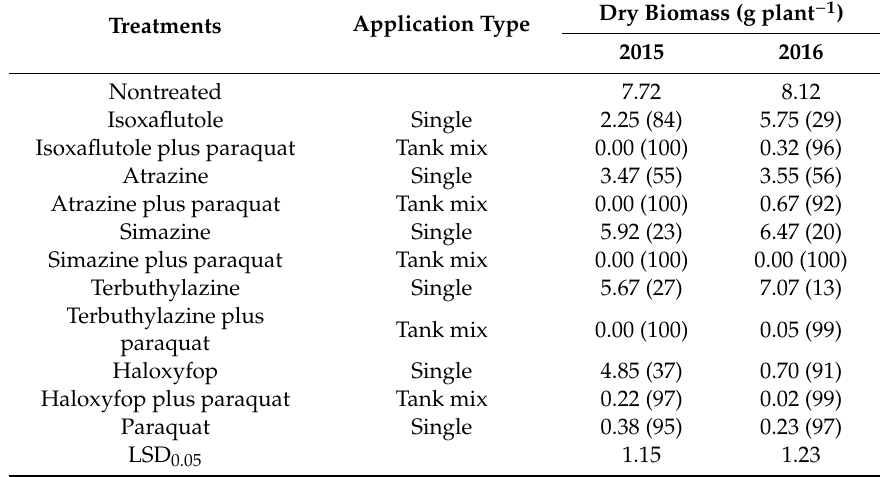
Table 3. E ff ect of single and tank mixture herbicide treatments on weed biomass at 42 d after treatment of flowering Echinochloa colona in pots over two separate experiments conducted in 2015 and